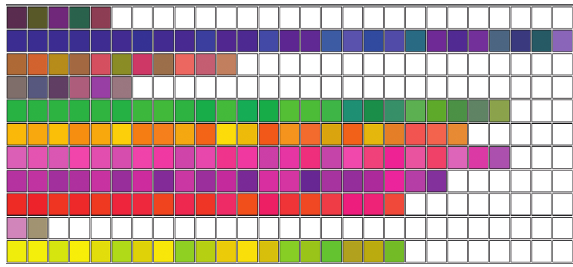
Figure 4: Color palette built from 288 artworks by Mark Rothko, Barnett Newman, and Clyfford Still—180 colors, 11 groups of colors. Up to down: black, blue, brown, grey, green, orange, pink, purple, red, white, and yellow.